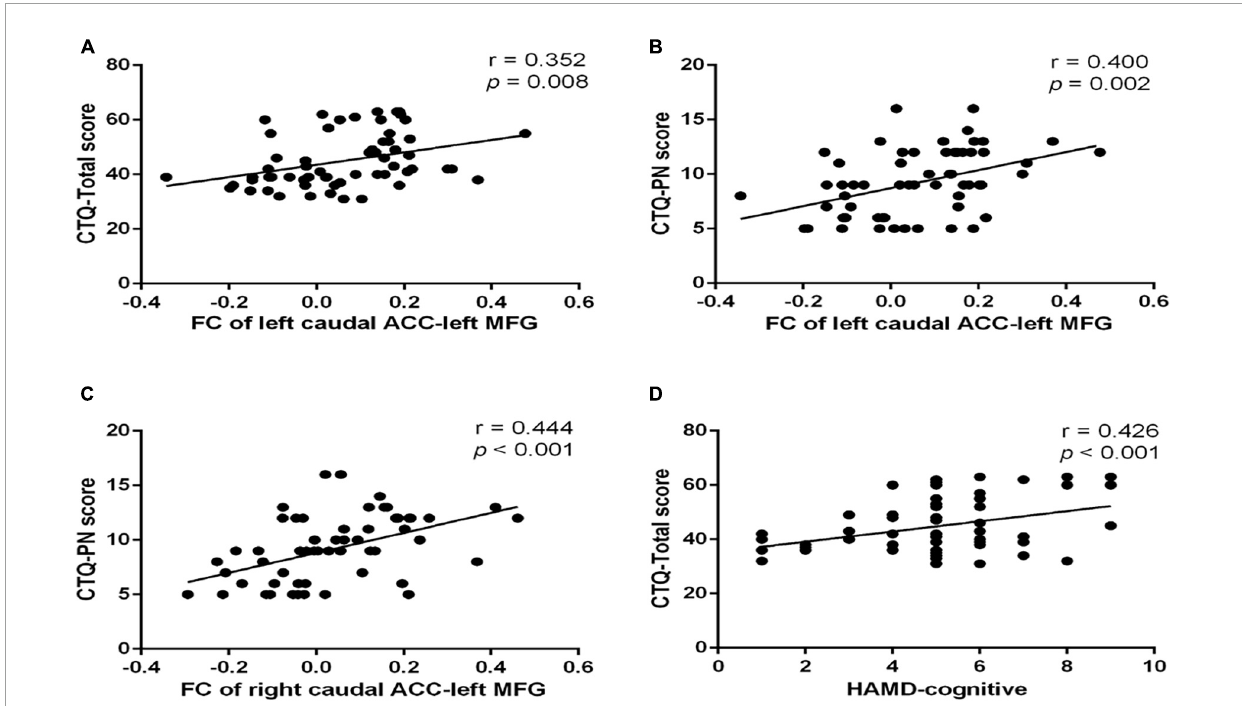
FIGURE4 Scatter plots of partial correlation between significant FC and the target scales in MDD group. (A) Positive partial correlation between FC of left caudal ACC to left MFG and CTQ total score. (B) Positive partial correlation between FC of left caudal ACC to left MFG and CTQ-Physical neglect score. (C) Positive partial correlation between FC of right caudal ACC to left MFG and CTQ-Physical neglect score. (D) Positive partial correlation between HAMD-cognitive and CTQ-Total score. All correlations showed in this figure were constructed after controlling gender, age, years of education, duration of illness, and mean frame displacement value. MDD, major depressive disorder; FC, functional connectivity; CTQ, Childhood Trauma Questionnaire; CTQ-EN, emotional neglect subscale of childhood trauma questionnaire; CTQ-PN, physical neglect subscale of childhood trauma questionnaire; ACC, anterior cingulate cortex; MFG, middle frontal gyrus.